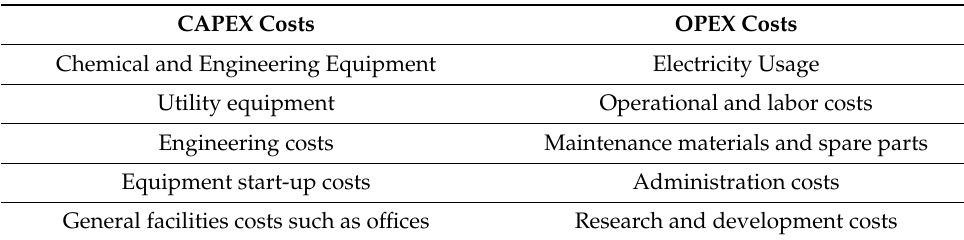
Table 5. Common CAPEX and OPEX costs in chemical